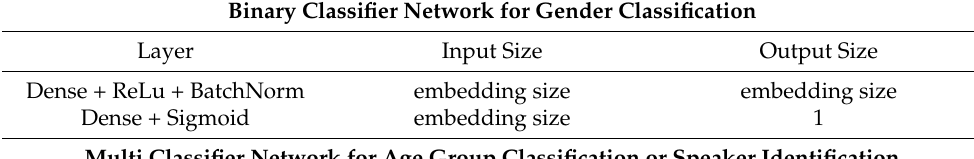
Table 4. The exact architectures of front-end modules.